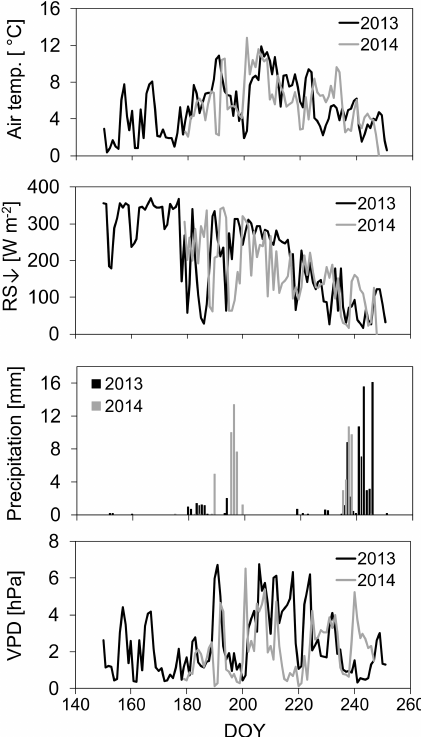
Figure 5. Growing seasons 2013 and 2014. Development of mean daily air temperature, precipitation, incoming solar radiation (RS ↓ ) and vapour pressure deficit (VPD) during the growing seasons in 2013 and 2014